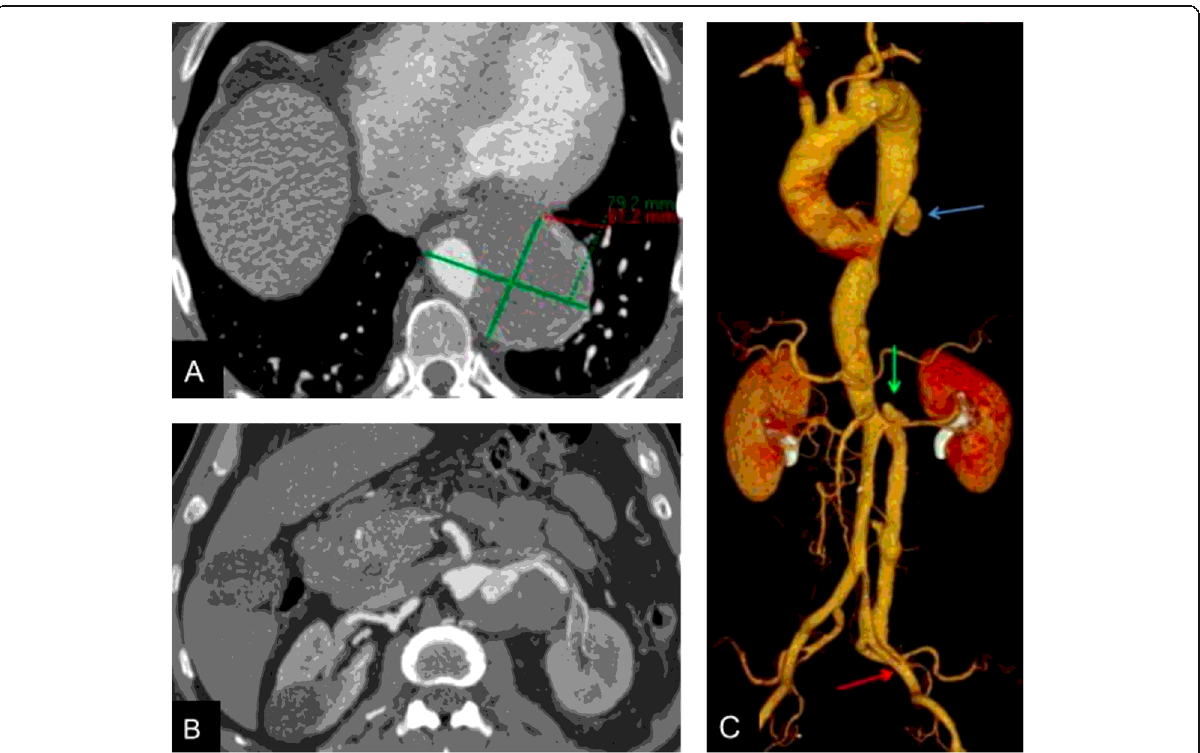
Fig. 1 A y B. Axial contrast-enhanced image; a Large periaortic intramural hematoma in sigmoid aorta. b Left renal artery arising from the TL with proximal reentry, associated aortic aneurysm. c 3D reconstruction showing an aortic ulcer in the descending aorta (blue arrow), re-entry of the FL at the level of the left renal artery (green arrow), and re-entry of the FL at the level of the left external iliac artery (red